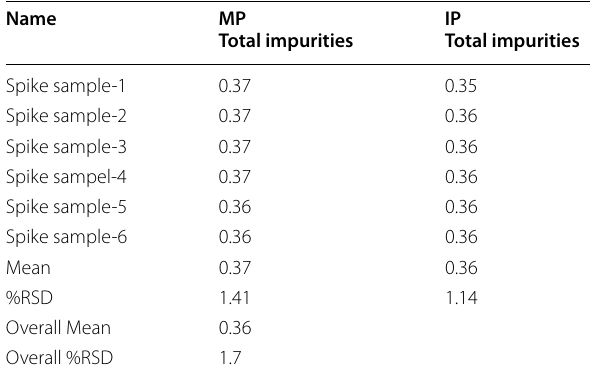
Table 10 Comparison of method precisions and